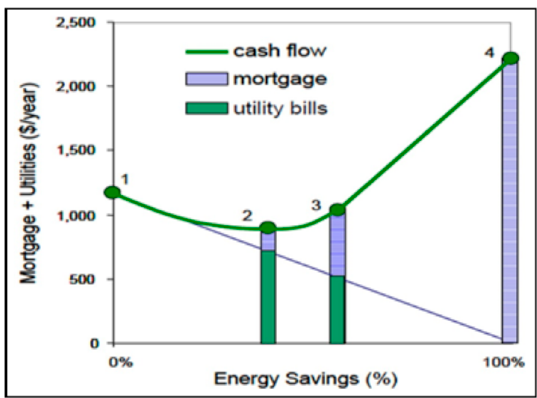
Figure 6. Costs of utilities (green) and mortgage (blue) versus energy savings from zero to 100% savings. Point 1 denotes the start, 2 the passive measures alone, and 3 the beginning of PV contribution (With permission of Wright & Klingenberg [31]).